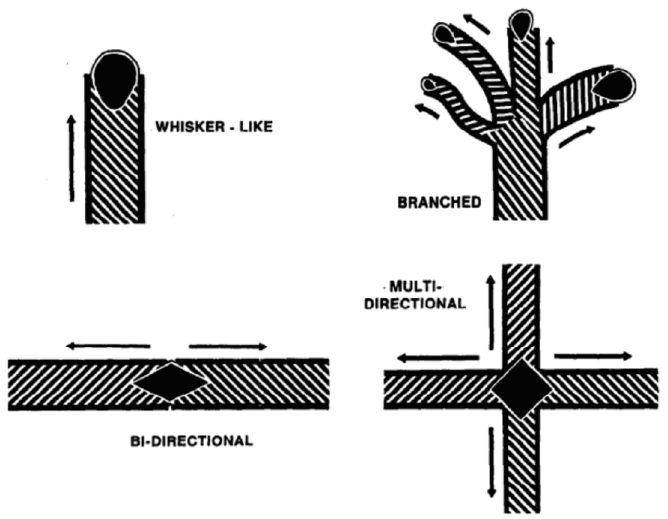
Figure 8. Schematic representation of different types of growth observed in carbon filaments [38]. Reprinted with permission from [38], Copyright 1989 Elsevier.